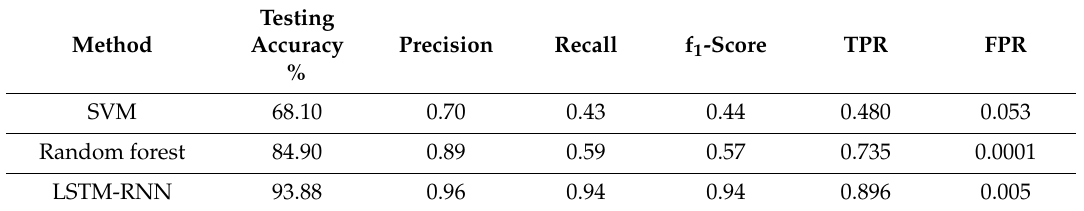
Table 13. Performance comparison for multi-class classification using 99